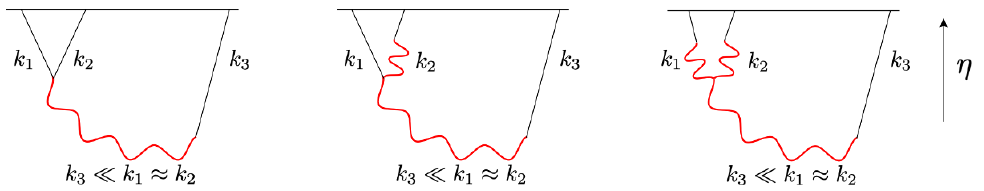
Figure 3 . Tree level contributions to bispectrum due to massive particle exchange. From left to right: (a) single exchange diagram, (b) double exchange diagram, (c) triple exchange diagram. All the three diagrams depend on the mixing between the massive particle (in red) and the in(cid:13)aton (cid:13)uctuation (in black) in the (implicit) non-trivial background of slowly rolling (cid:30) 0 ( t ). (cid:17) is (conformal) time, ending at the end of